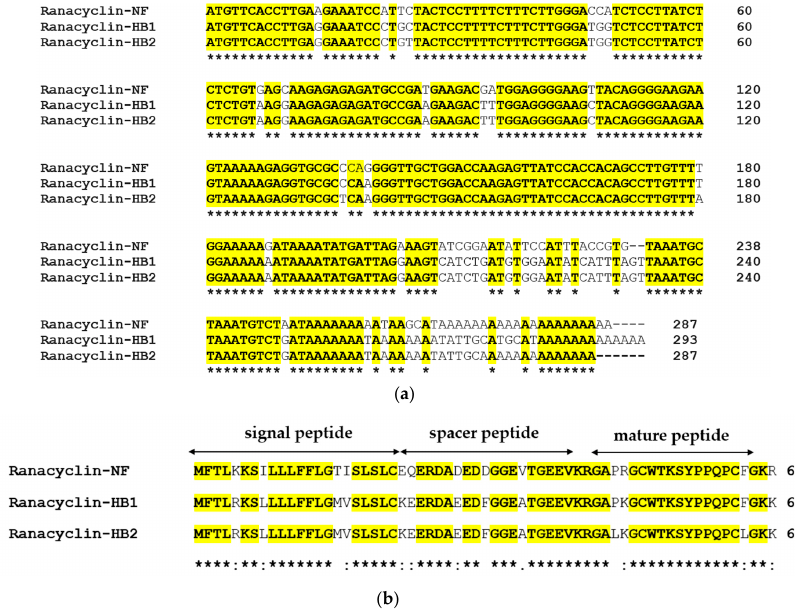
Figure 2. ( a ) Alignment of precursor cDNA nucleotides of RNF, ranacyclin-HB1 and ranacyclin-HB2; and ( b ) alignment of precursor cDNA translated peptides of RNF, ranacyclin-HB1 and ranacyclin-HB2. Asterisks indicate identical nucleotides/amino acids (in ( a , b )) and colons (:) indicate chemically- conserved amino acids (in ( b )).